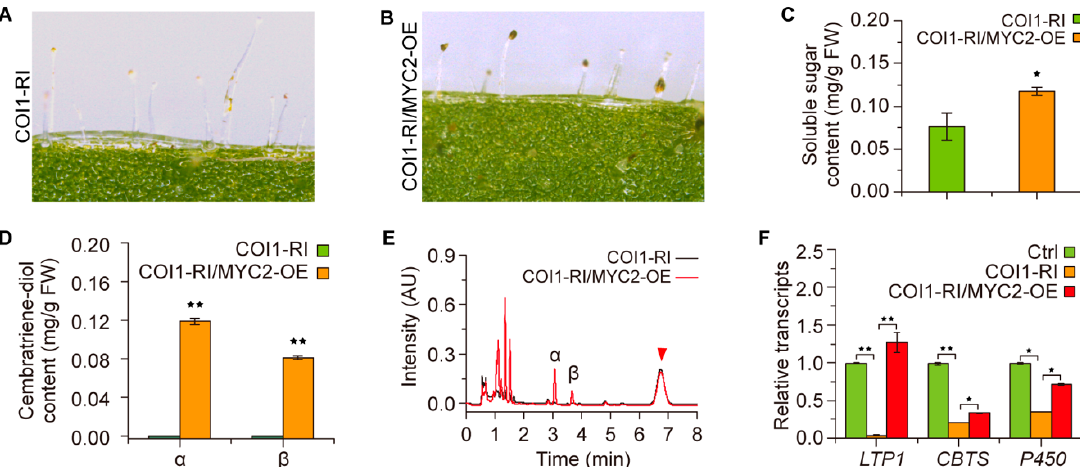
Figure 5. Regulatory roles of NtMYC2a in COI1-mediated cembratriene-diol formation in tobacco. ( A , B ) Trichome secretion droplets staining with I 2 /KI for plants with dysfunction of COI1 (COI1-RI) and overexpressing NtMYC2a in plants with dysfunction of COI1 (COI1-RI/MYC2-OE). ( C ) Soluble sugar content of the trichome secretion droplets in the plants of COI1-RI and COI1-RI/MYC2-OE. ( D ) Comparison of cembratriene-diol contents between the plants of COI1-RI and COI1-RI/MYC2-OE. ( E ) The representative chromatogram profiles of cembratriene-diol determination by the UPLC system for the plants of COI1-RI and COI1-RI/MYC2-OE. The triangle indicates the unidentified compound observed in above results. ( F ) Transcription profiles of the cembranoid synthetic genes LTP1 , CBTS and P450 in the plant set of the control (Ctrl), COI1-RI and COI1-RI/MYC2-OE. The transcription level of each gene in the control (Ctrl) plants was arbitrarily set as “1”. Values in ( C , D , F ) are the average of data from three independent lines with triplicate measurements. Asterisks in ( C , D , F ) indicate significant difference from the plants of COI1-RI. Error bars, mean ± SE.